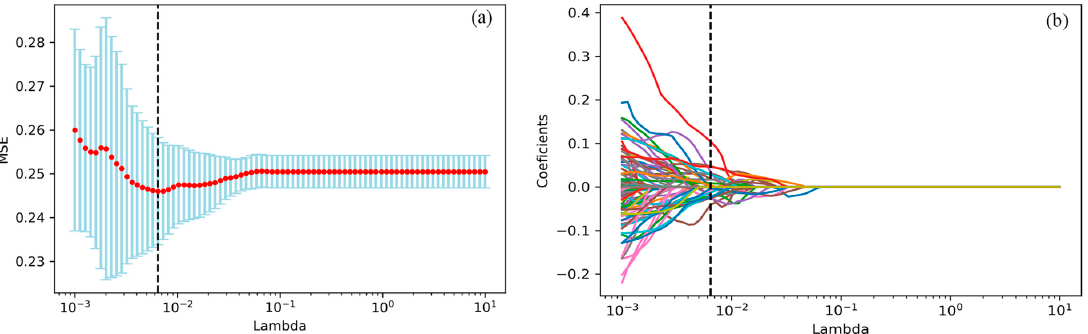
Figure 2. the LASSO algorithm for features selection. ( a ) The mean square error path using ten-fold cross-validation. ( b ) LASSO coefficient profile of 622 features, where 31 features with non-zero coefficients were selected. Table 3. Feature selection by LASSO regression. (Top 10).